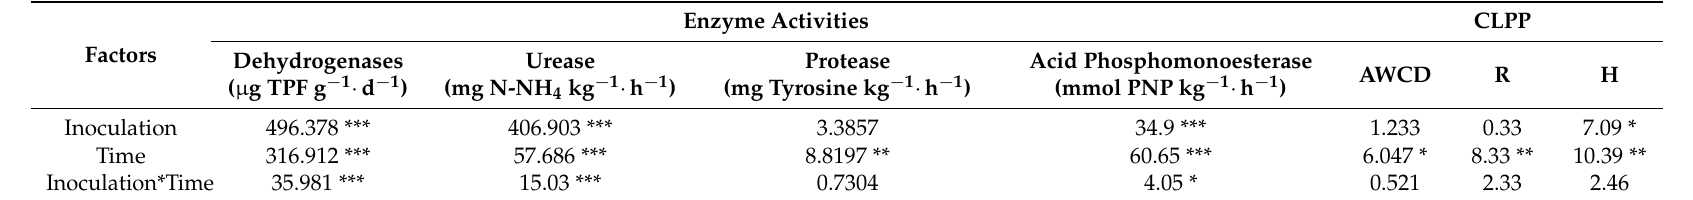
Table 2. F -values for enzyme activities and Community Level Physiological Profiling (CLPP)